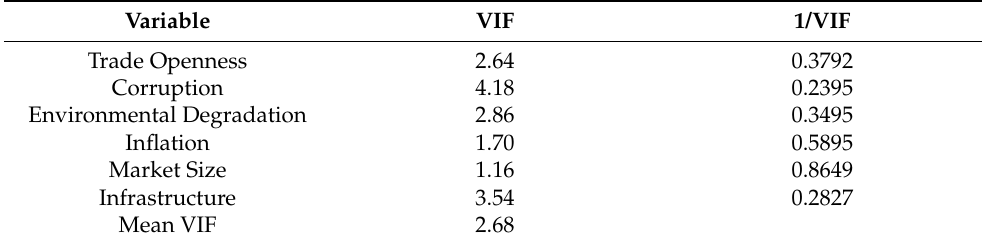
Table 3. Variance Inflation Factor (VIF)